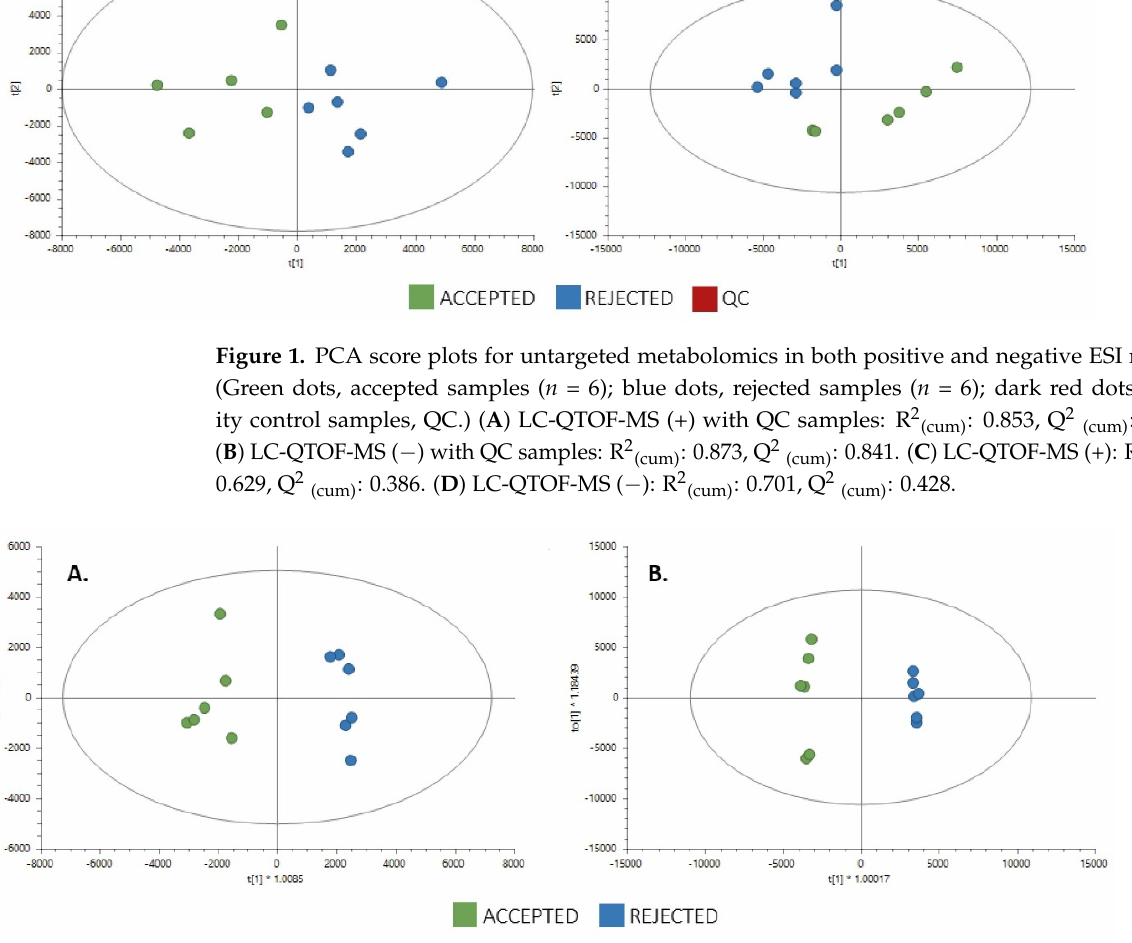
Figure 2. Comparison of the supervised OPLS-DA models for untargeted metabolomics of rejected samples ( n = 6) vs. accepted samples ( n = 6). (Green dots, accepted samples ( n = 6); blue dots, rejected samples ( n = 6)). ( A ): Positive ESI mode comparison LC-QTOF-MS (+): R2X(cum): 0.394, R2Y(cum):0.0965, Q2 (cum): 0.691, CV-ANOVA: 0.056. ( B ) Negative ESI mode—LC-QTOF-MS ( − ): R2X(cum): 0.868, R2Y(cum): 0.997, Q2 (cum): 0.974, CV-ANOVA: 0.00063.